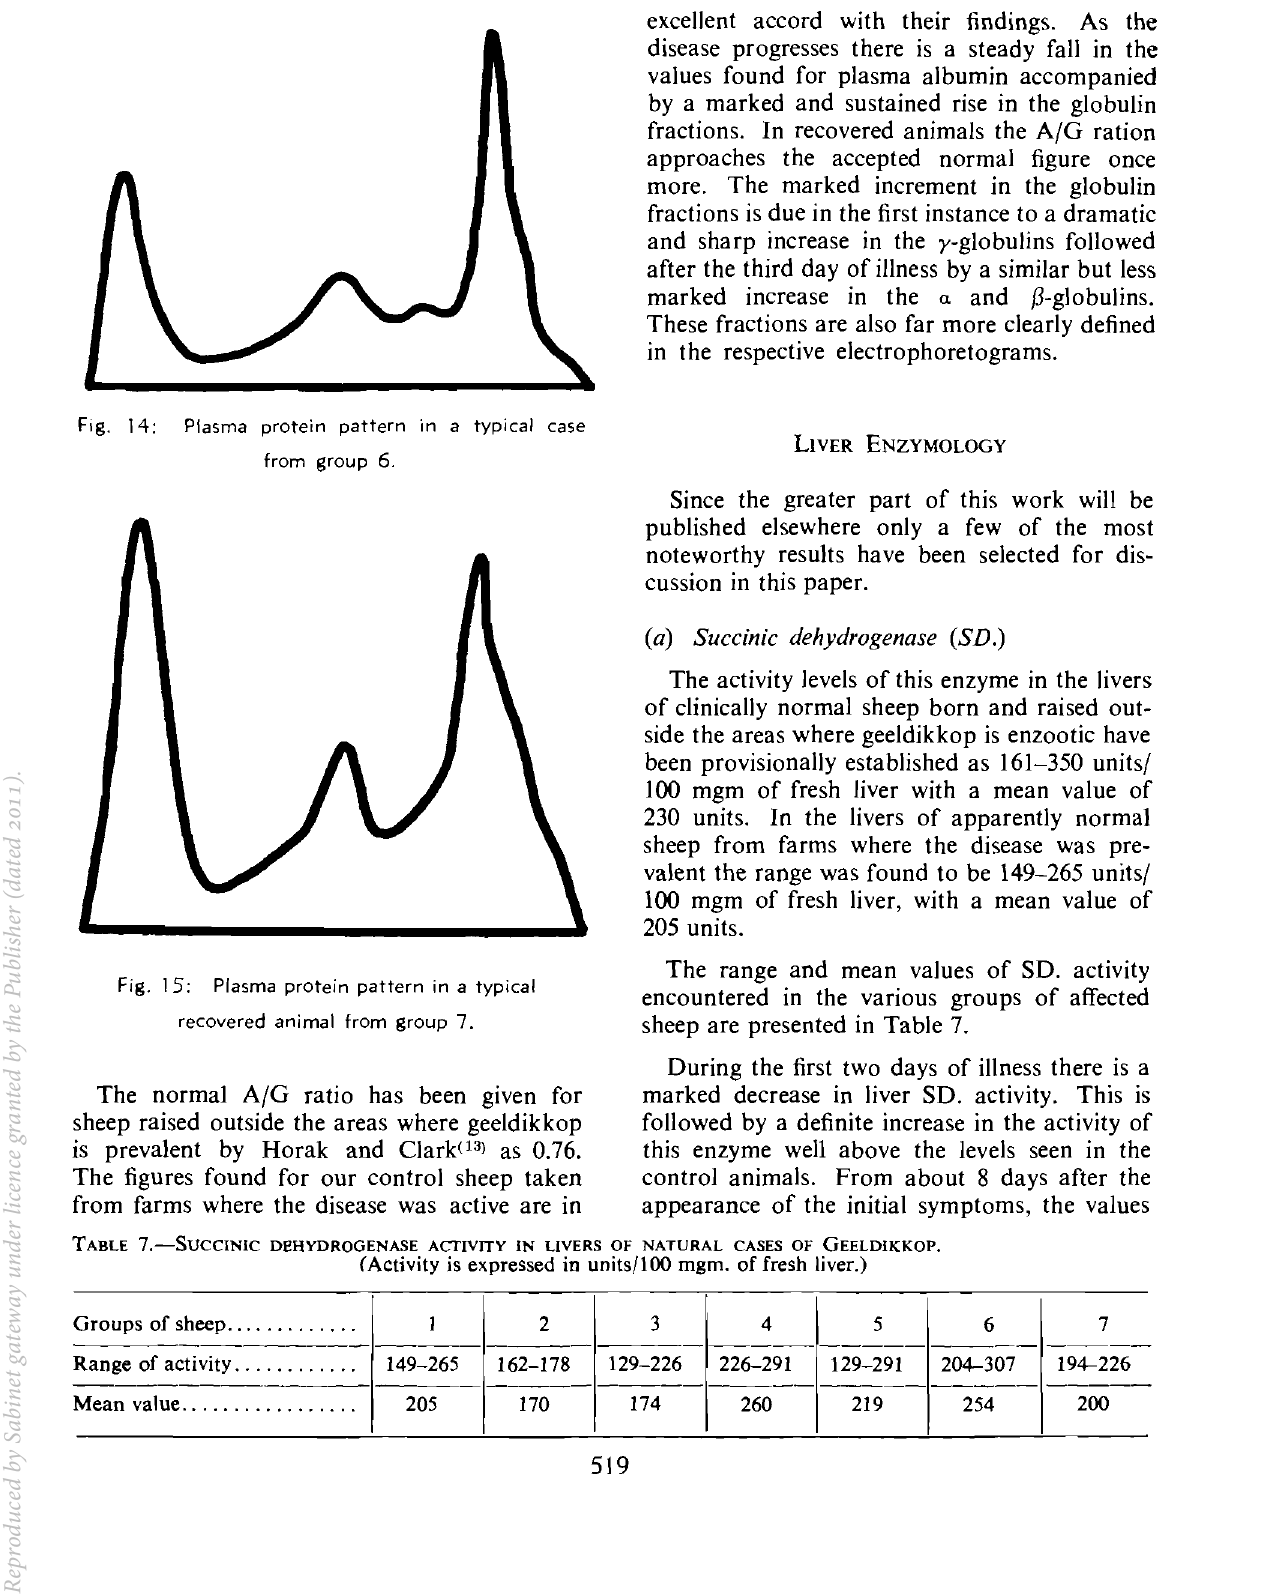
Fig. 14: Plasma protein pattern in a typical case from group 6.